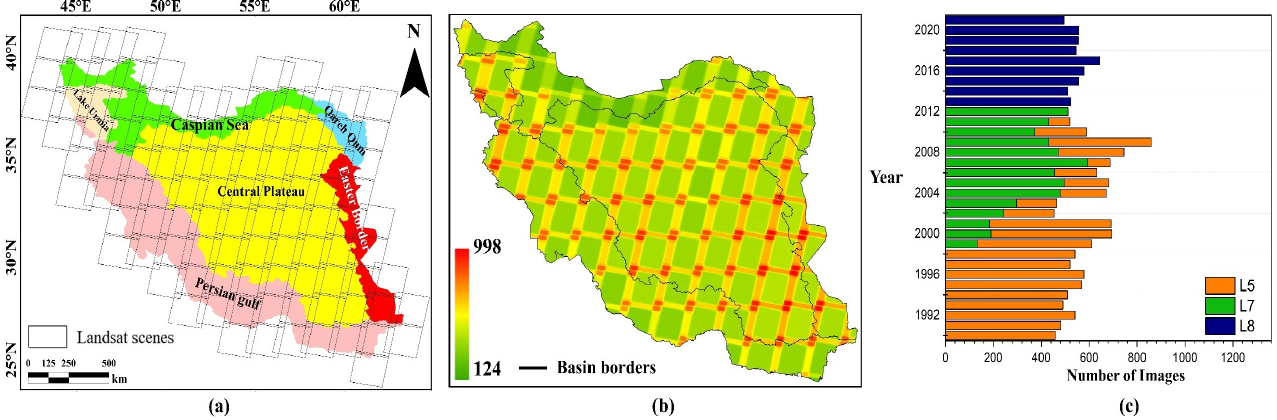
Figure 2. ( a ) Landsat scenes covering Iran’s different basins; ( b ) number of observations per pixel during 32 years of study; ( c ) total number of images used in each year.